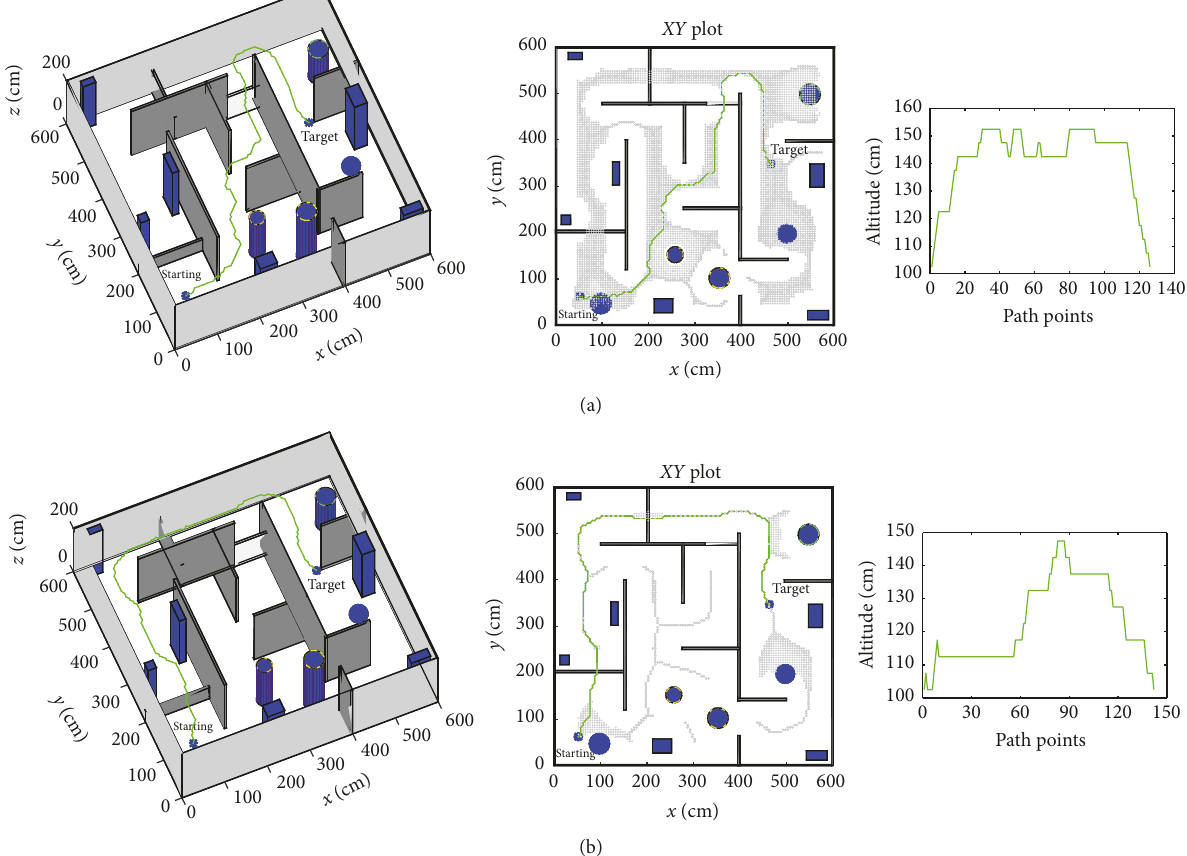
Figure 3: Shortest path computed on the FMS based on different UAV sizes (20 cm (a), 40cm (b)) with the altitude (right column) plotted for each